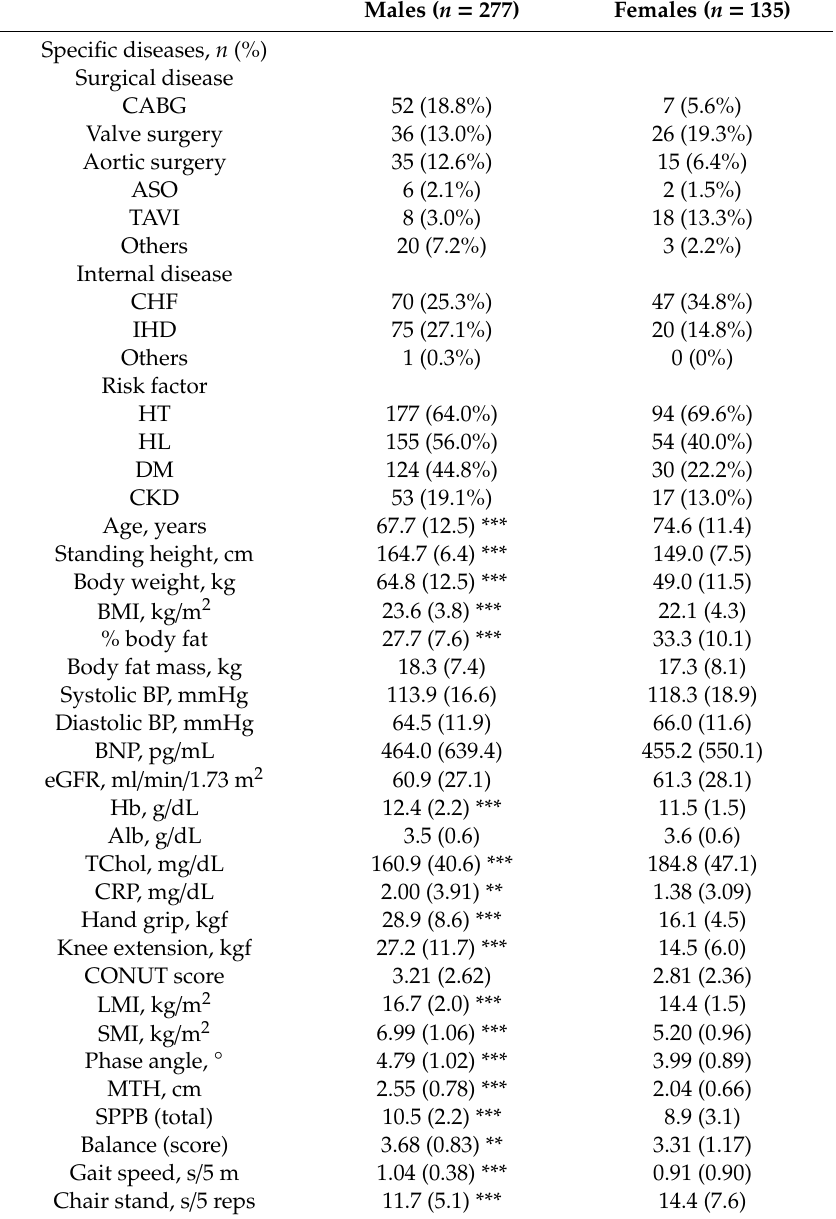
Table 1. Patient physical characteristics and clinical